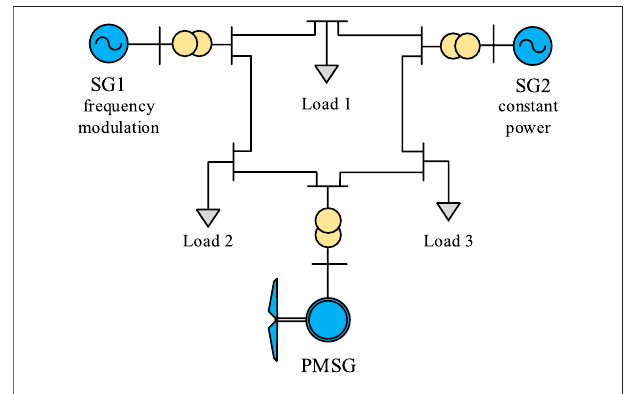
FIGURE 1 | 3-machine 9-node networking system